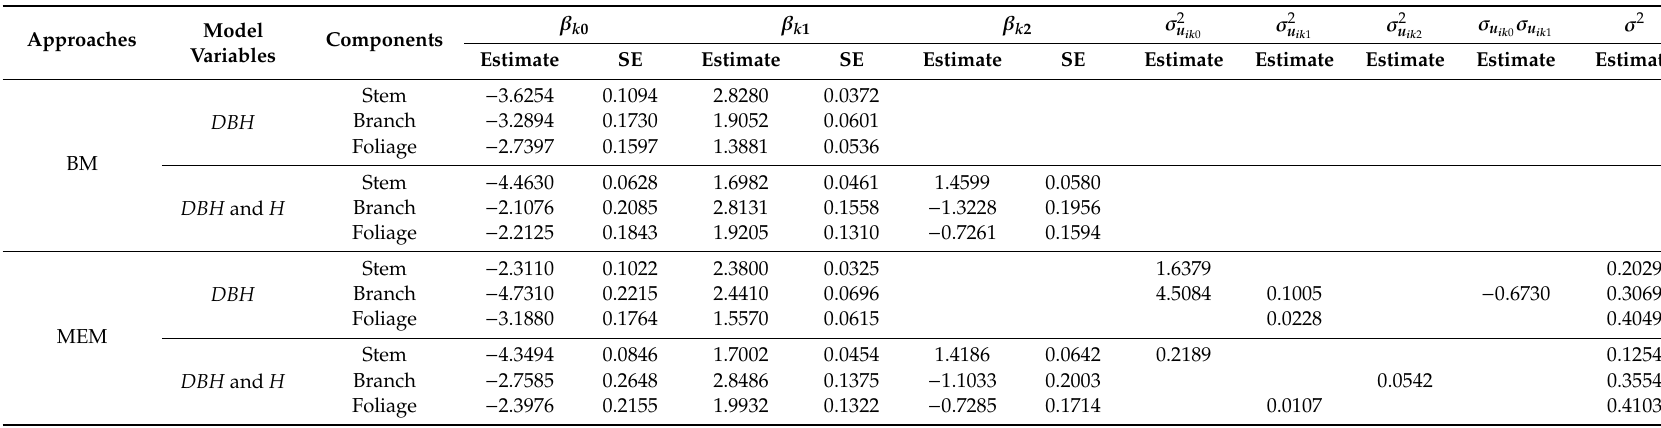
Table 2. Parameter estimates and their standard errors (SE) for the base Model (BM) [Equations (1) and (2)] and mixed E ff ects Model (MEM) [Equations (3) and (4)]. β β β k 0 , k 1 and k 2 : fixed parameters; u ik 0 , u ik 1 and u ik 2 : random e u ik 0 and u ik 1 ; σ 2 : residual